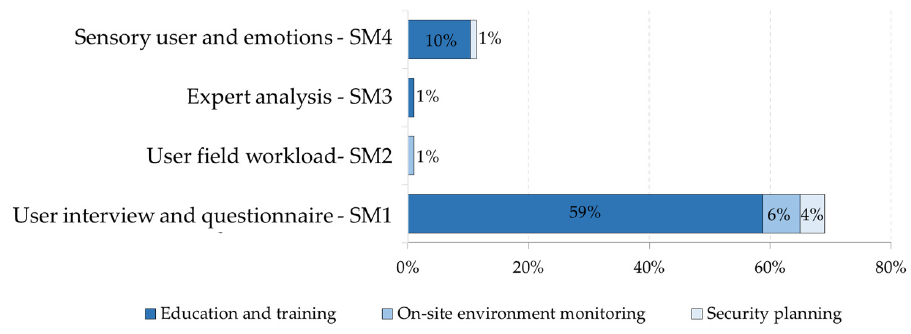
Figure 9. Number of items for each safety-related purpose by type of subjective method evaluation.